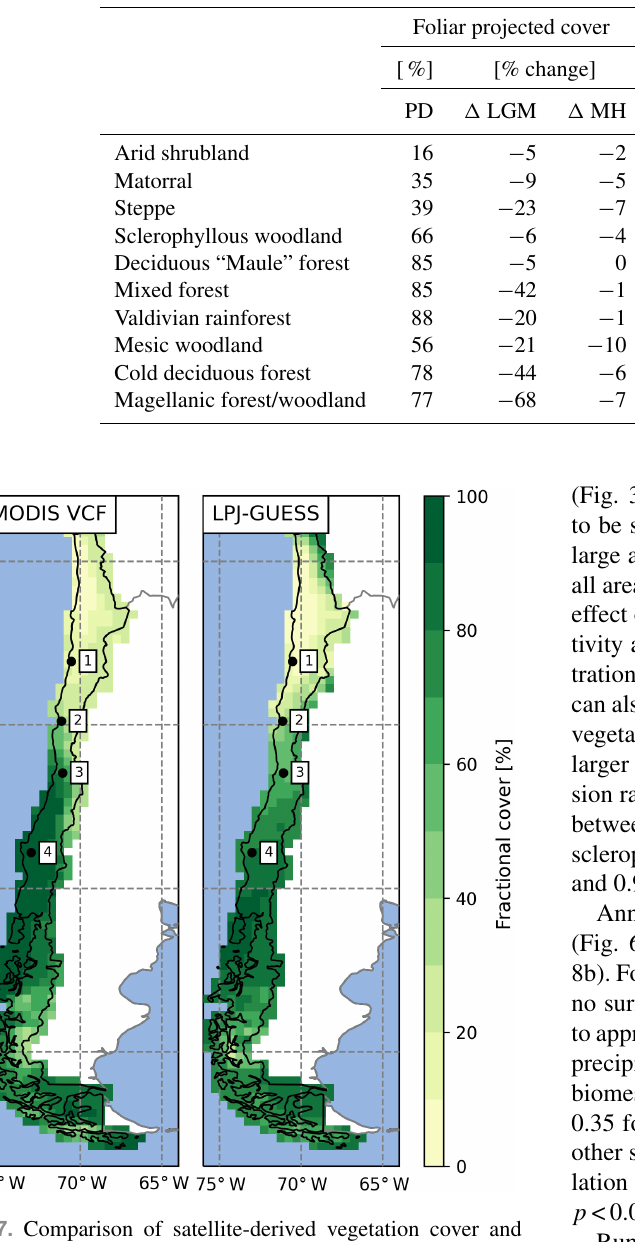
Table 3. Average foliar projected cover (FPC) and annual surface runoff for simulated biomes for present day (PD) and relative change within these PD areas for the Last Glacial Maximum ( (cid:49) LGM, LGM-PD) and the mid-Holocene ( (cid:49) MH, MH–PD).